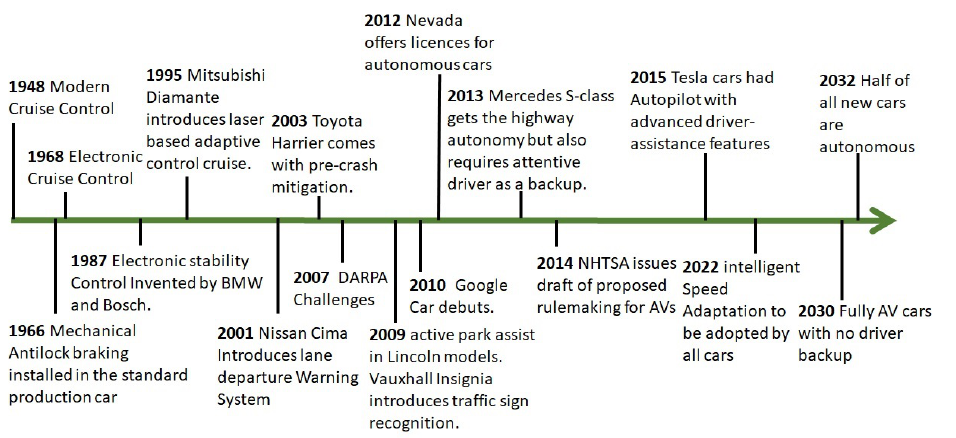
Figure 2. Technical evolution in autonomous